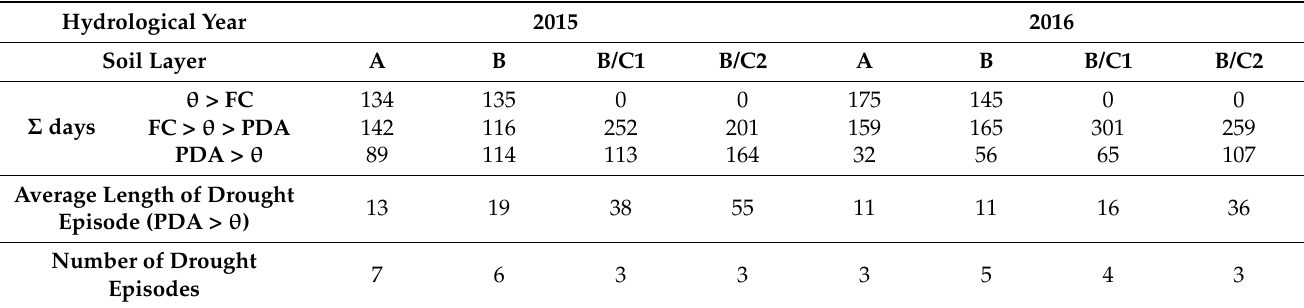
Table 9. Summary of the days with water contents ( θ ) within certain hydrolimits (FC—field capacity and PDA—point of decreased availability) and characteristics of a